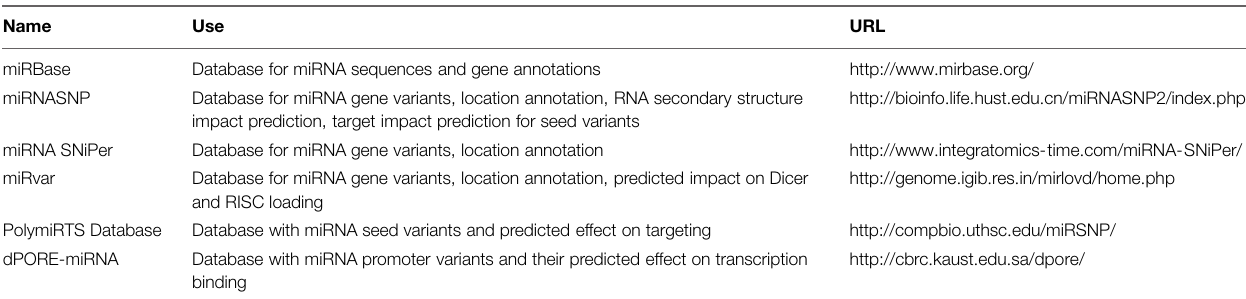
TABLE 1 | Overview of described